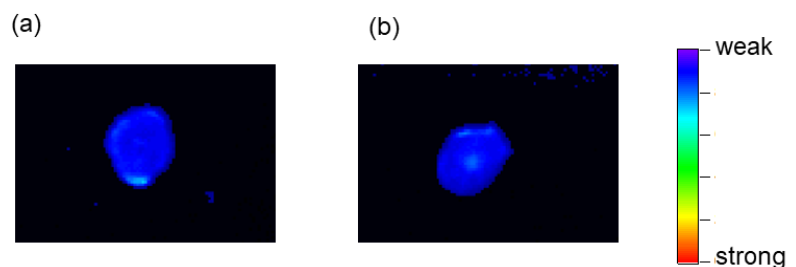
Figure 6. Representative images of tumor tissues visualized using the TFMAQ-diEg4 emission. Images from groups 4 ( a ) and 5 ( b ) are shown.